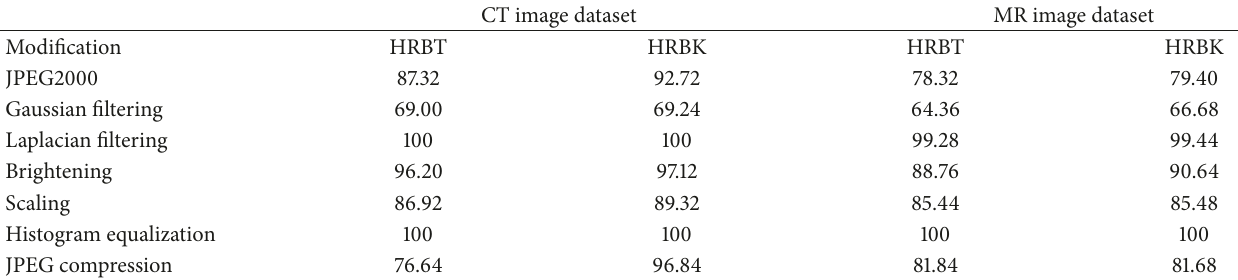
Table 5: Multiclass detection rates (%) with HRBT and HRBK features. CT image dataset